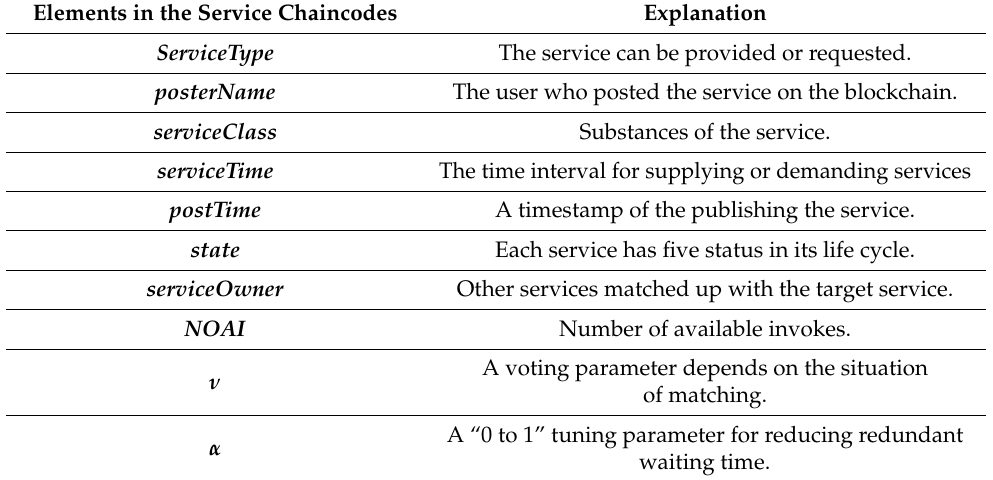
Table 1. The parameters in the service proposal.